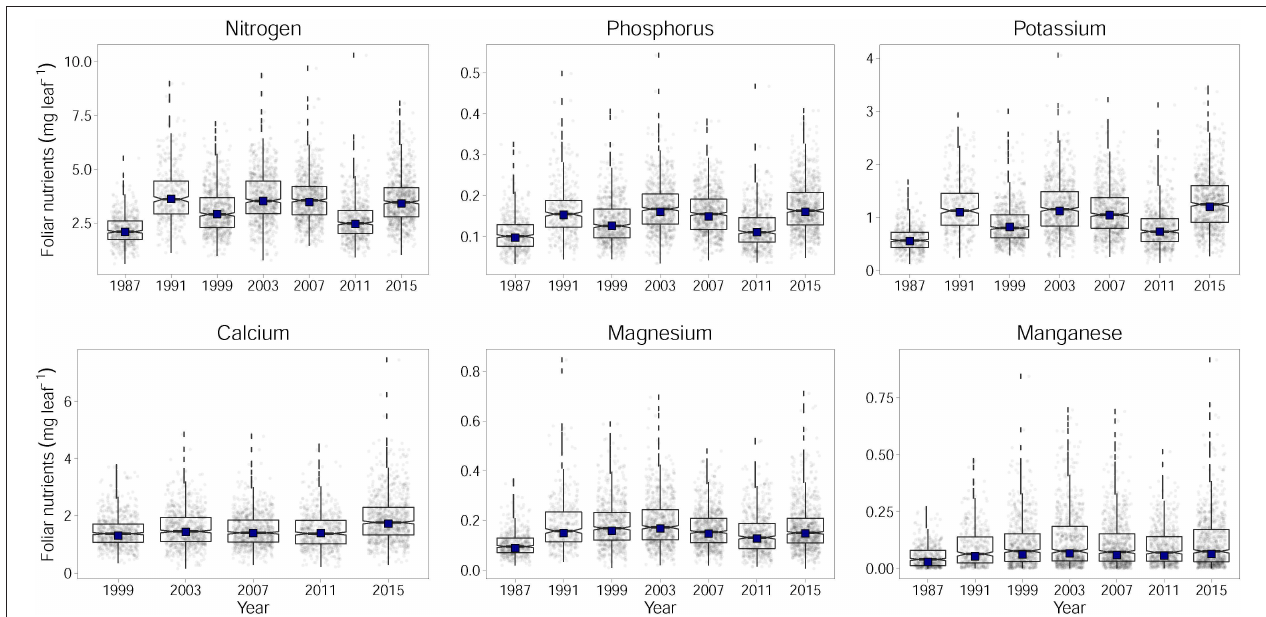
FIGURE 2 | Development of foliar contents for N, P, K, Ca, Mg, and Mn for Fagus sylvatica calculated per leaf. Adjusted annual levels for the annually changing set of plots (by considering plot as a random effect) with year as fixed effect are given as black squares. The development is different when foliar contents are looked at instead of foliar concentrations ( Figure 2 ). This contrasting development of concentrations and contents is mainly due to increasing leaf dry weight ( Figure_Supplementary 4 ): while the specific leaf area slightly decreased throughout the observation period, leaf area increased (data not shown).